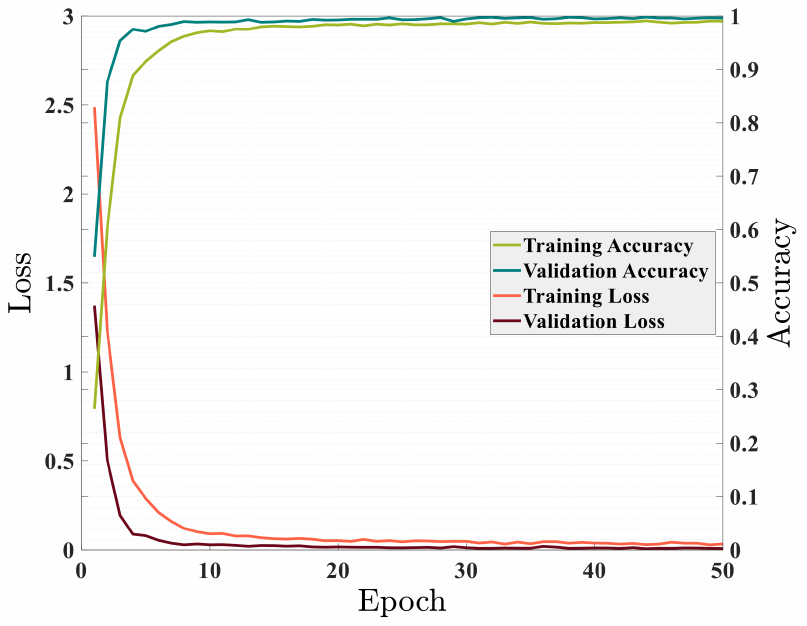
Figure 7. Accuracy and loss on train and validation sets without DGs penetration in the